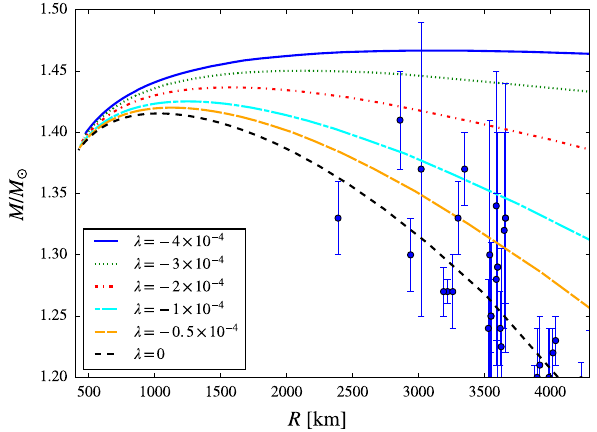
Fig. 2 Mass as a function of the radius for massive WDs with different values of λ . The blue circles with error bars represent the observational data of a sample of massive WDs taken from the catalogs